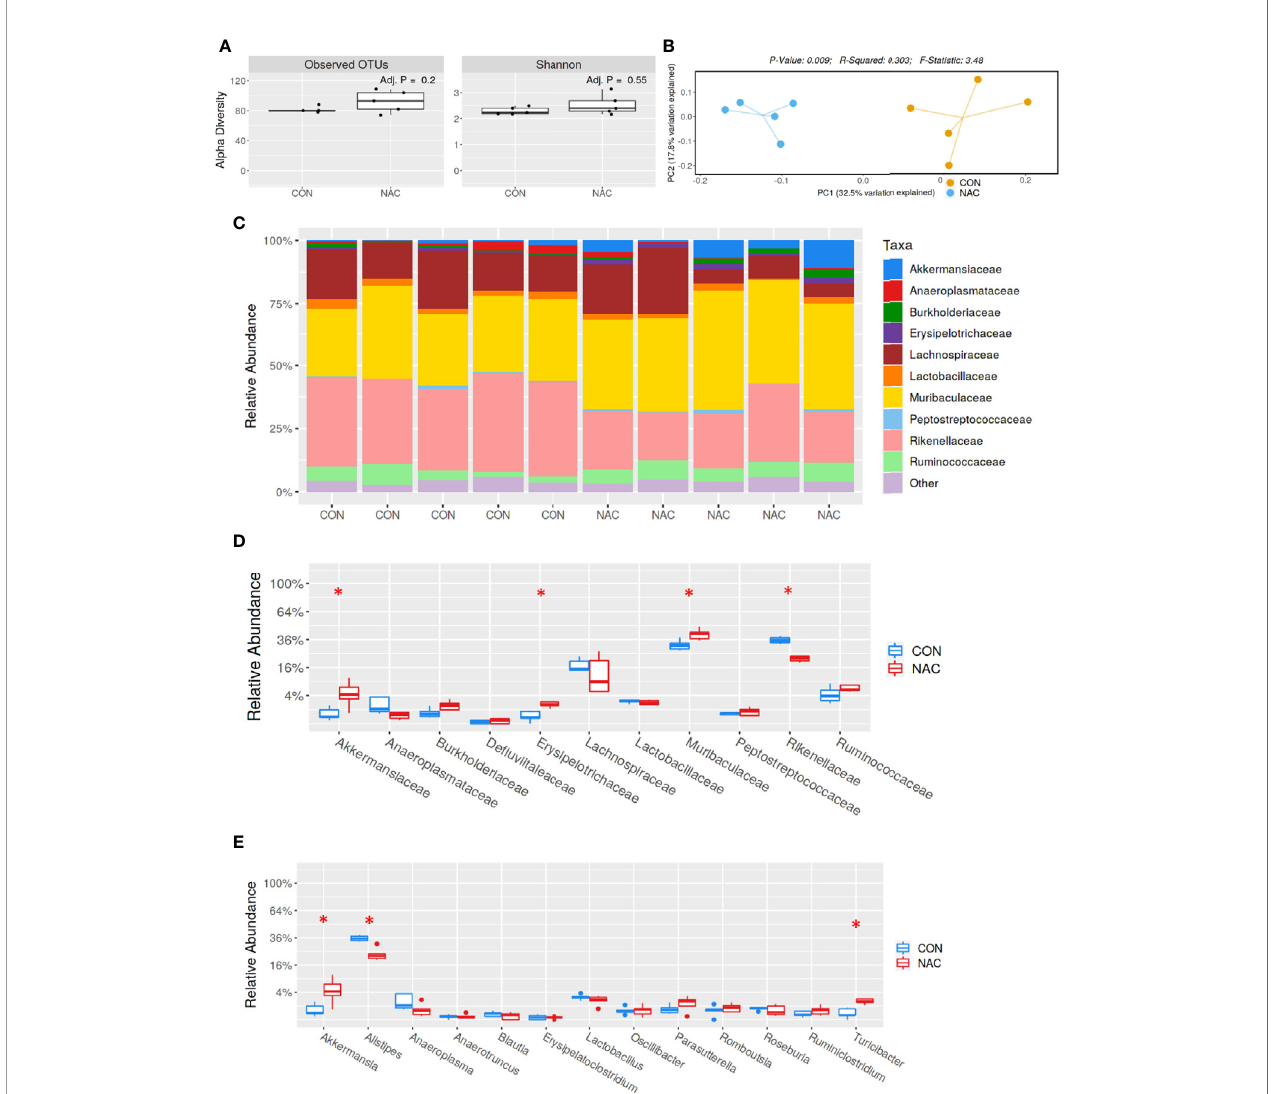
FIGURE 8 | Gut microbiome changes after antioxidant NAC treatment in MRL/lpr mice. Bacterial DNA was isolated from fecal pellets of CON and NAC-treated MRL/lpr mice, and 16s rDNA sequencing was performed to evaluate the microbiome composition in each mice. (A) The variety of organisms in a community termed as alpha diversity. (B) Different mouse strains showed distinct microbiome pattern. (C) Stacked bar plot for composition of common bacterial taxa (>0.1% abundance). (D) Taxa relative abundance at family level. (E) Taxa relative abundance at genus level. Results are mean ± SEM. n = 5 * p <